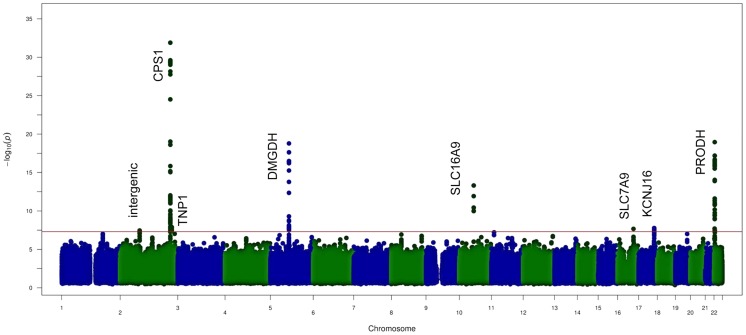
GWAS results of the NMR metabolites.Figure shows the aggregated Manhattan plot for the 42 metabolites studied. Red line shows the suggestive genome-wide significance level with a P-value of 5×10−8.Loci harbouring DMGDH, SLC16A9, PRODH and CPS1 are reported as metabolome wide significance.